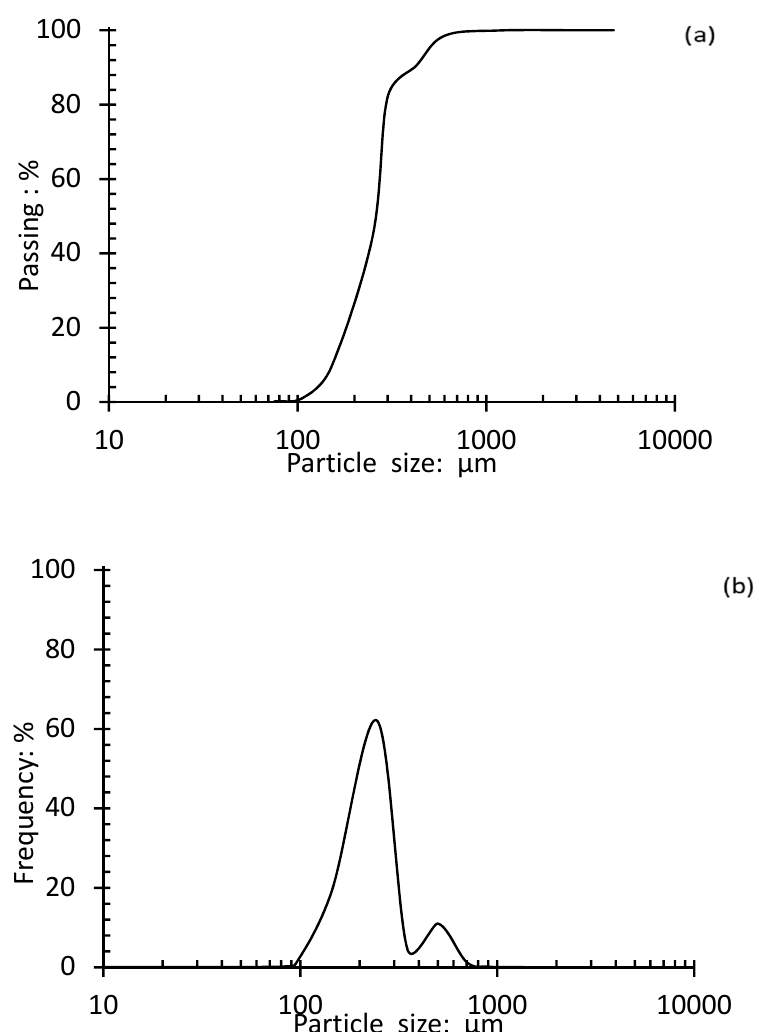
Figure 1. Grading quality for F161 sand: ( a ) particle size distribution; ( b ) mode size distribution.